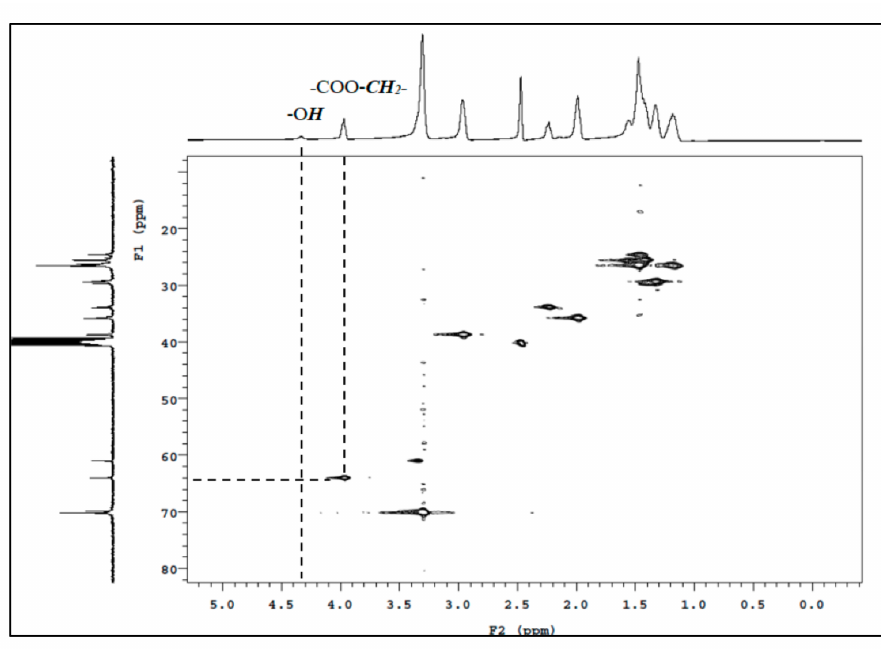
Figure 6. HMQC spectra of PEBA 250.